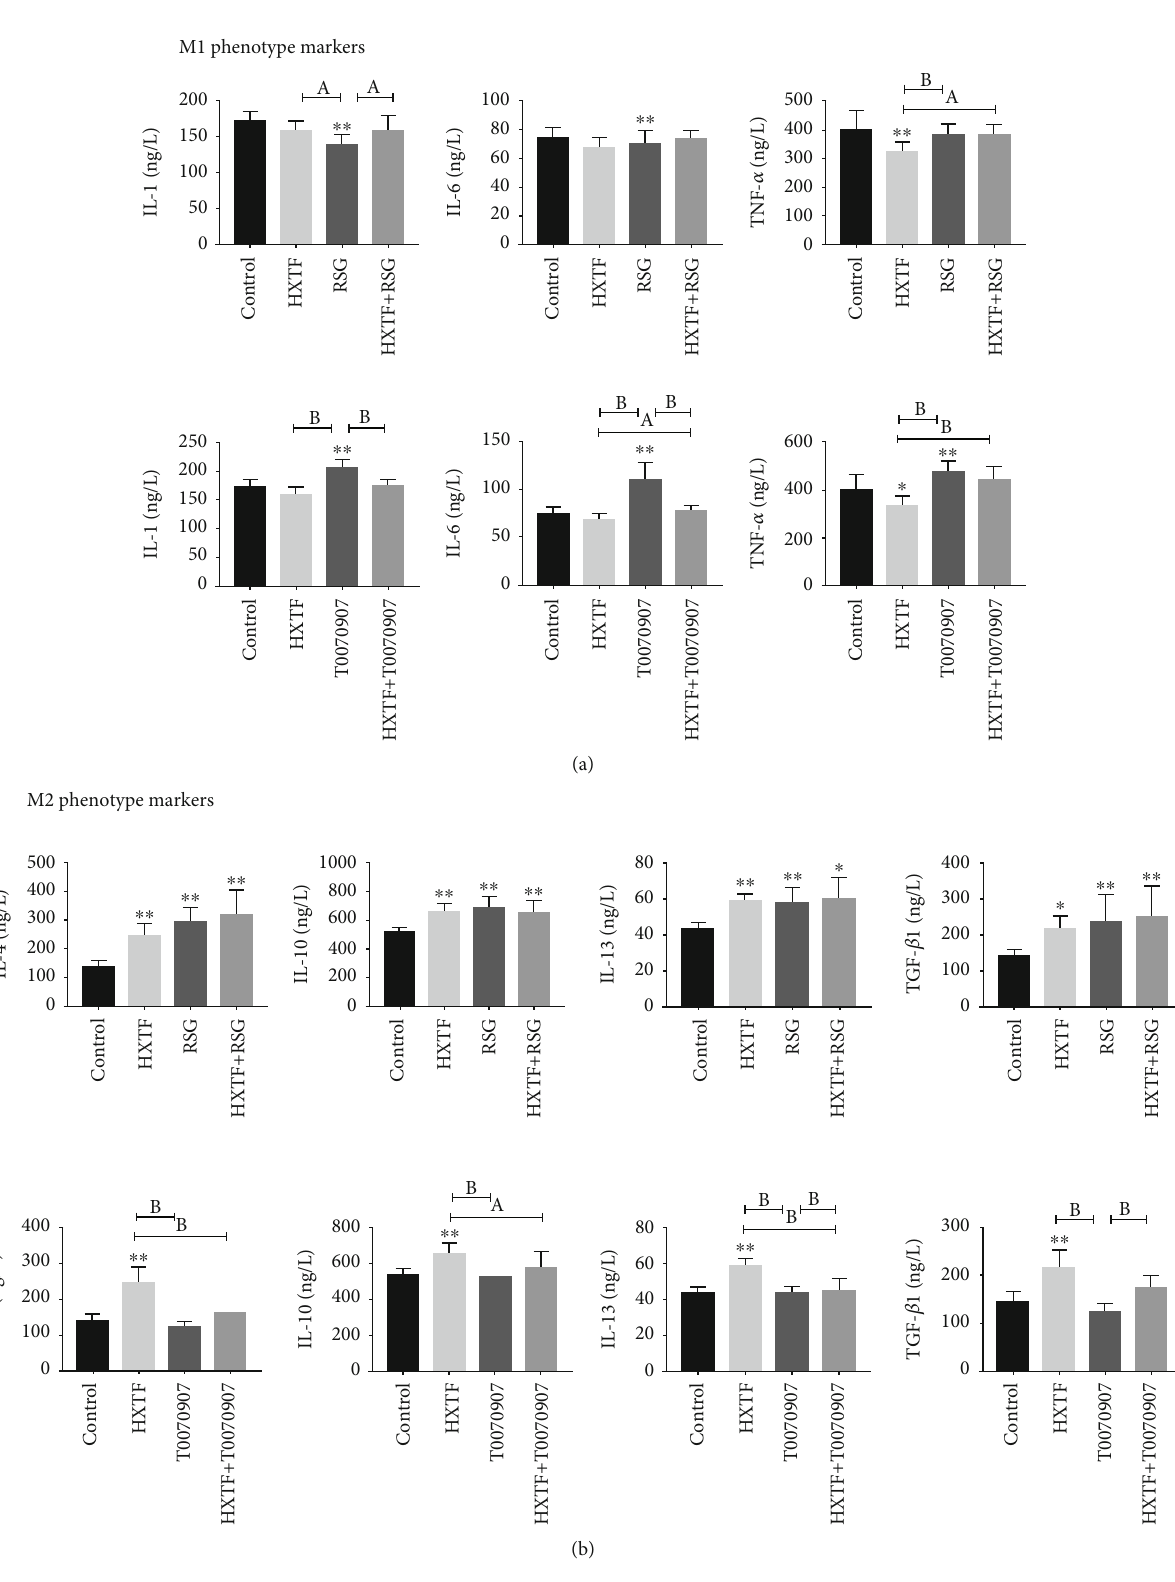
Figure 6: ModulationofPPAR- γ activityonM1/M2markers.RAW264.7cellswerepreincubated witheither rosiglitazone(RSG)(1 μ mol/mL) or T0070907 (1 μ mol/mL) for 3h, followed by combined treatment with/without HuoXueTongFu Formula (HXTF) for 12h. (a) ELISA analysis of M1 gene marker expression on macrophages. (b) ELISA analysis of M2 gene marker expression on macrophages. All values are expressed as mean ± S : E : ( n = 3 experiments). ∗ p < 0 : 05 , ∗∗ p < 0 : 01 , a p < 0 : 05 , and b p < 0 : 01 , comparison of the designated two